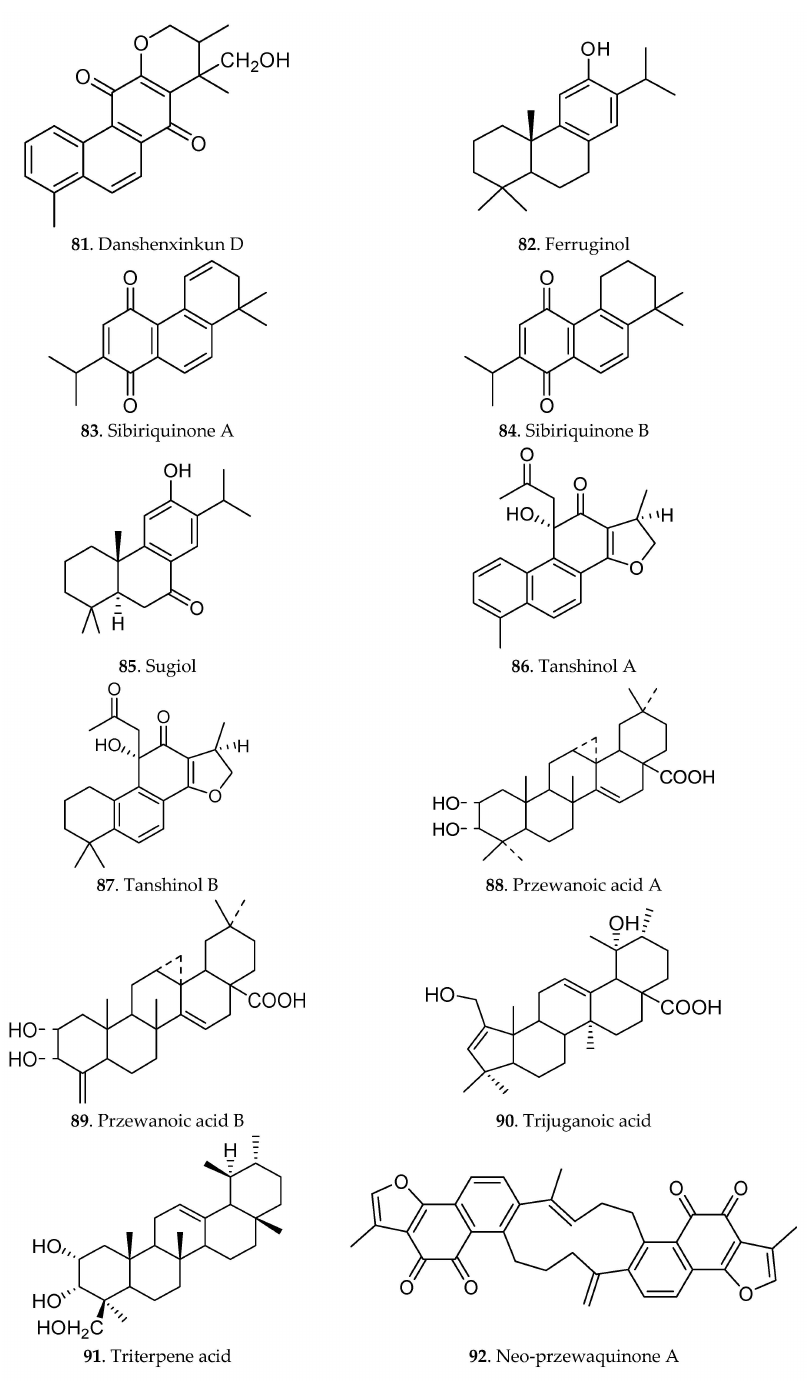
Figure 3. Terpene quinines in Radix Salviae